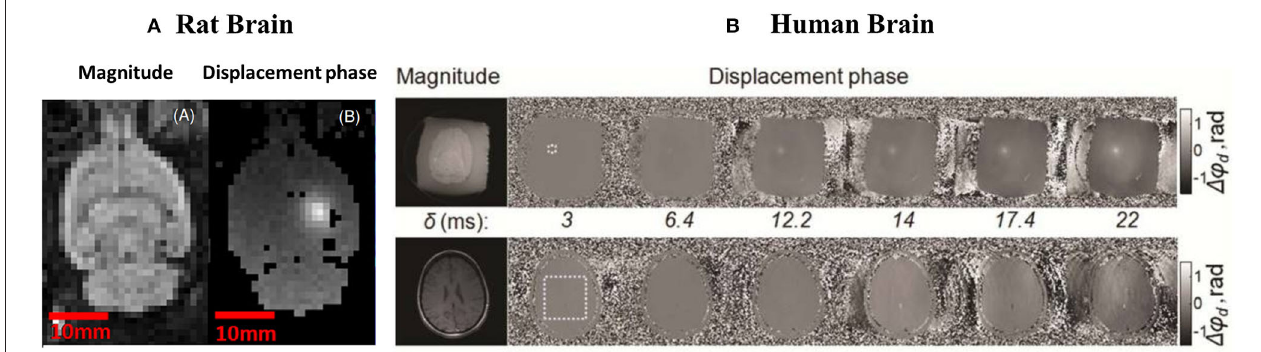
FIGURE 3 | (A) Magnitude (A) and phase image (B) obtained by [42] through and ARFI sequence. The bright spot in figure (B) represents the FUS focal spot. Figure adapted with permission from [42]. (B) : in vitro (above) and in vivo (bottom) MR acoustic radiation force images of a human brain [43]. On the left and right part of the figure, magnitude and phase images are shown, respectively. Higher values of tissue displacements ( 1 φ d ) in phase images acquired for different duration of encoding gradients ( δ ) indicate FS location. Figure adapted with permission from [43].